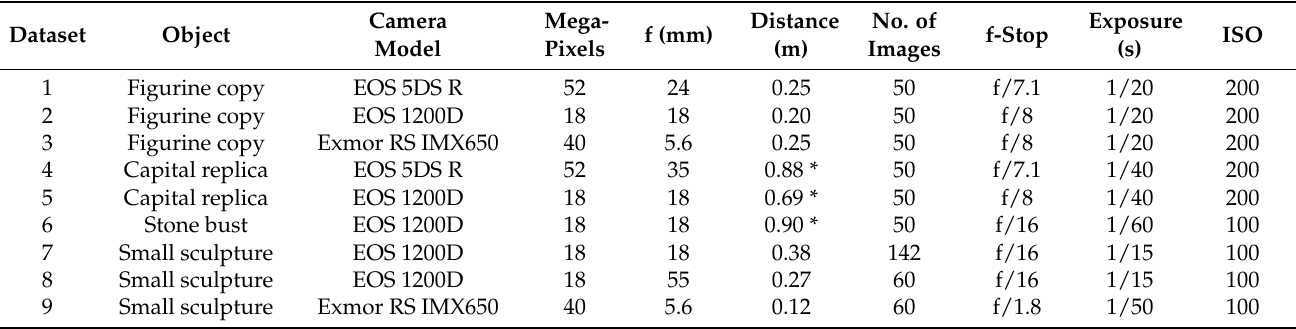
Table 2. Characteristics of imagery